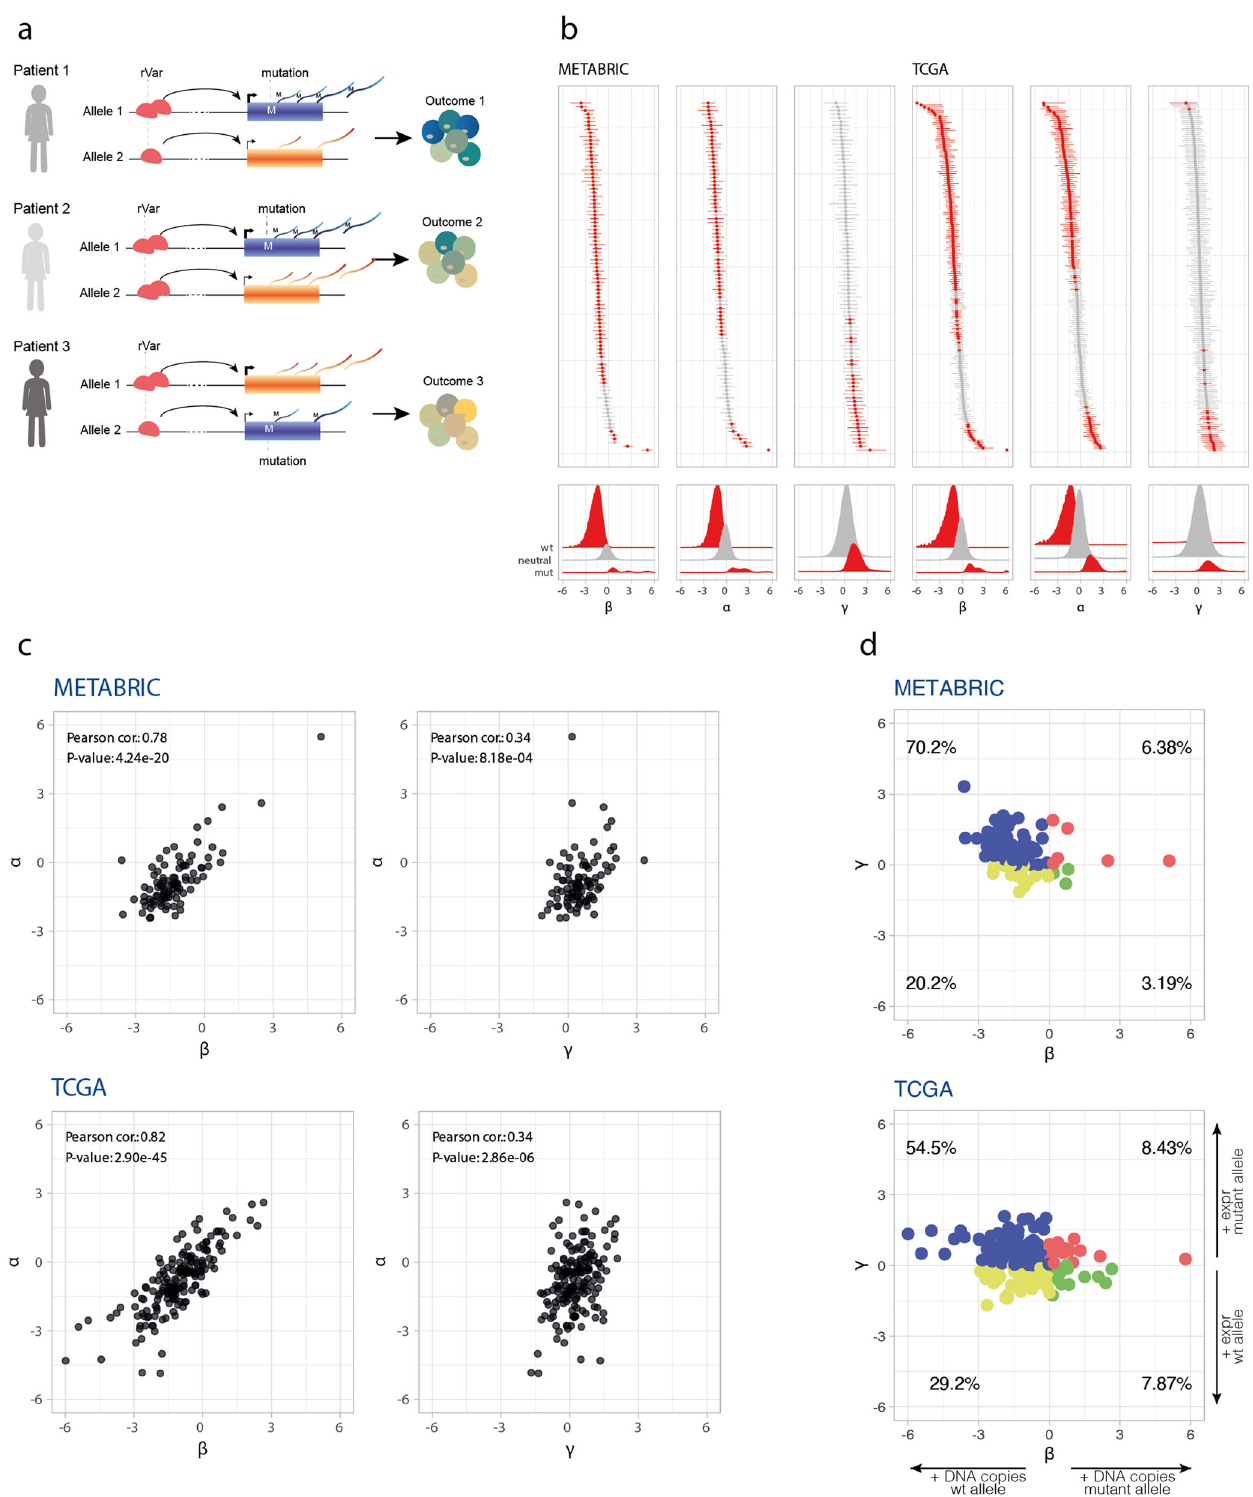
Fig. 2 Mutant allelic imbalance in gene expression of somatic missense PIK3CA mutations is frequent in breast tumors, particularly for preferential expression of the mutant allele. a Schematic representation of the hypothesis: cis-acting regulatory variants (rVar), either from germline or somatically acquired, generate different relative allelic expression ratios of mutant and wild-type alleles, resulting in tumors of different prognosis. b Top: log ratio α , β , and γ 89% credible intervals (CI) in breast tumors. Bottom: CIs collective posterior distribution split according to imbalance. A sample is deemed imbalanced if the CI does not cross zero. Samples with signi fi cant imbalance are displayed in red. c Correlation analysis of α vs. β and α vs. γ , showing that both genomic copy-number dosage and allelic expression regulation contribute to imbalances in the expression of mutated alleles in tumors. Point coordinates are Maximum A Posteriori probability estimates (MAP) of the 89% CIs. d Comparison of matched γ and β values, showing predominance of tumors with a preferential allelic expression of the mutated allele. Point coordinates are Maximum A Posteriori probability estimates (MAP) of the 89%